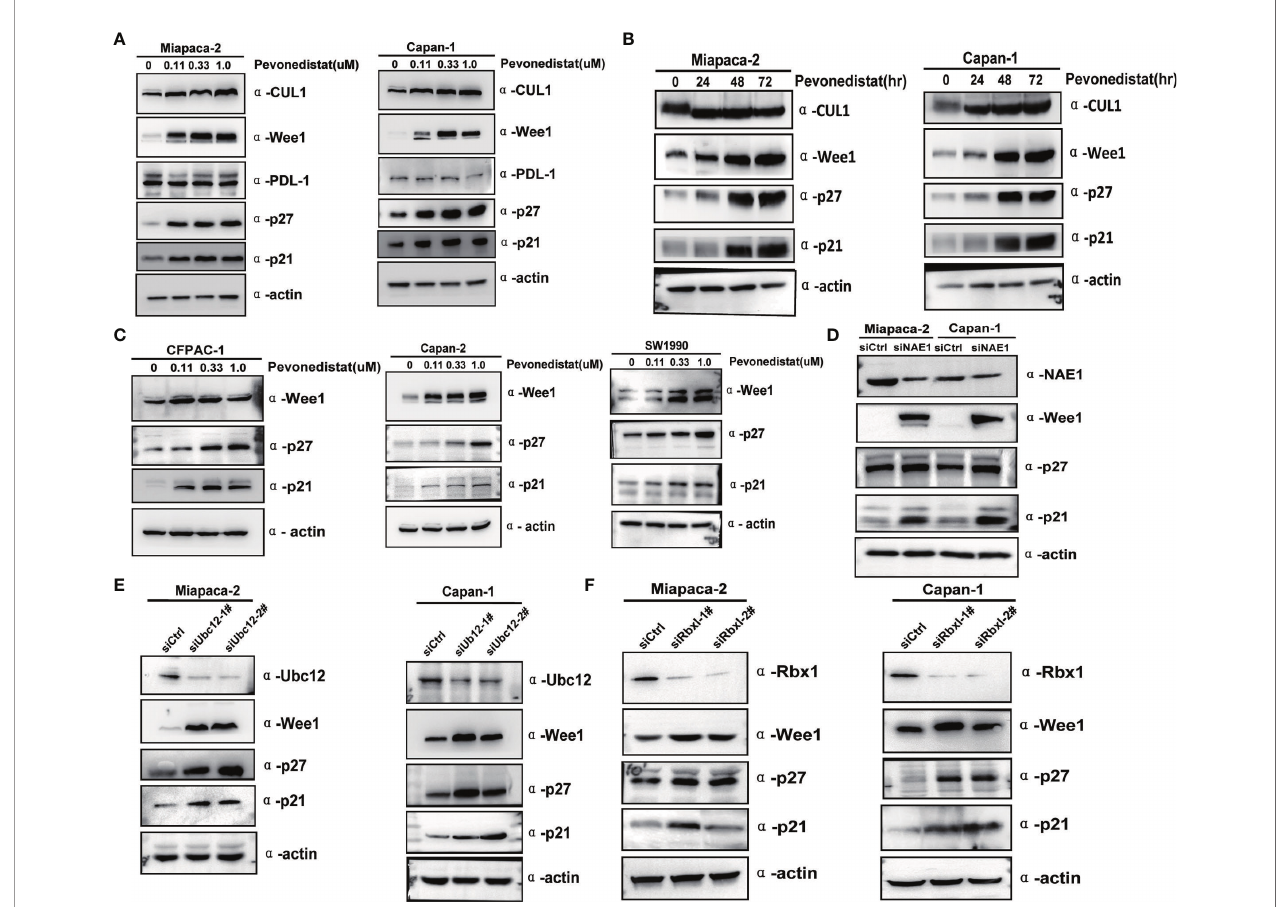
FIGURE 4 | Inactivation of the neddylation pathway induced the accumulation of client proteins Wee1, p27, and p21. (A) Pevonedistat induced accumulation of Wee1, p27, and p21 in a dose-dependent manner. Forty-eight hours after Miapaca-2 and Capan-1 cells were treated with pevonedistat at increasing concentrations (0.1, 0.3, and 1.0 m M) vs. dimethyl sulfoxide (DMSO), cells were subjected to immunoblotting using antibodies against Cullin 1, Wee1, p27, and p21 with actin as a loading control. (B) Pevonedistat induced accumulation of Wee1, p27, and p21 in a time-dependent manner. Miapaca-2 and Capan-1 cells were treated with 1.0 m M of pevonedistat at increasing time points and then subjected to immunoblotting using antibodies against Cullin 1, Wee1, p27, and p21 with actin as a loading control. (C) Pevonedistat induced accumulation of Wee1, p27, and p21 in other pancreatic cancer cells. Forty-eight hours after CFPAC-1, Capan-2 and SW1990 cells were treated with pevonedistat at increasing concentrations (0.1, 0.3, and 1.0 m M) vs. DMSO, and cells were subjected to immunoblotting using antibodies against Cullin 1, Wee1, p27, and p21 with actin as a loading control. (D) siRNA knockdown NAE1 caused upregulation of Wee1, p27, and p21. Miapaca-2 and Capan-1 cells were transfected by siNAE1 and siCtrl for 72 h and then subjected to immunoblotting using antibodies against NAE1, Wee1, p27, and p21 with actin as a loading control. (E) siRNA knockdown Ubc12 led to upregulation of Wee1, p27, and p21. Miapaca-2 and Capan-1 cells were transfected by siUbc12 and siCtrl for 72 h and then subjected to immunoblotting using antibodies against Ubc12, Wee1, p27, and p21 with actin as a loading control. (F) siRNA knockdown Rbx1 resulted in upregulation of Wee1, p27, and p21. Miapaca-2 and Capan-1 cells were transfected by siRbx1 and siCtrl for 72 h and then subjected to immunoblotting using antibodies against Rbx1, Wee1, p27, and p21 with actin as a loading control. These data were representative of three independent